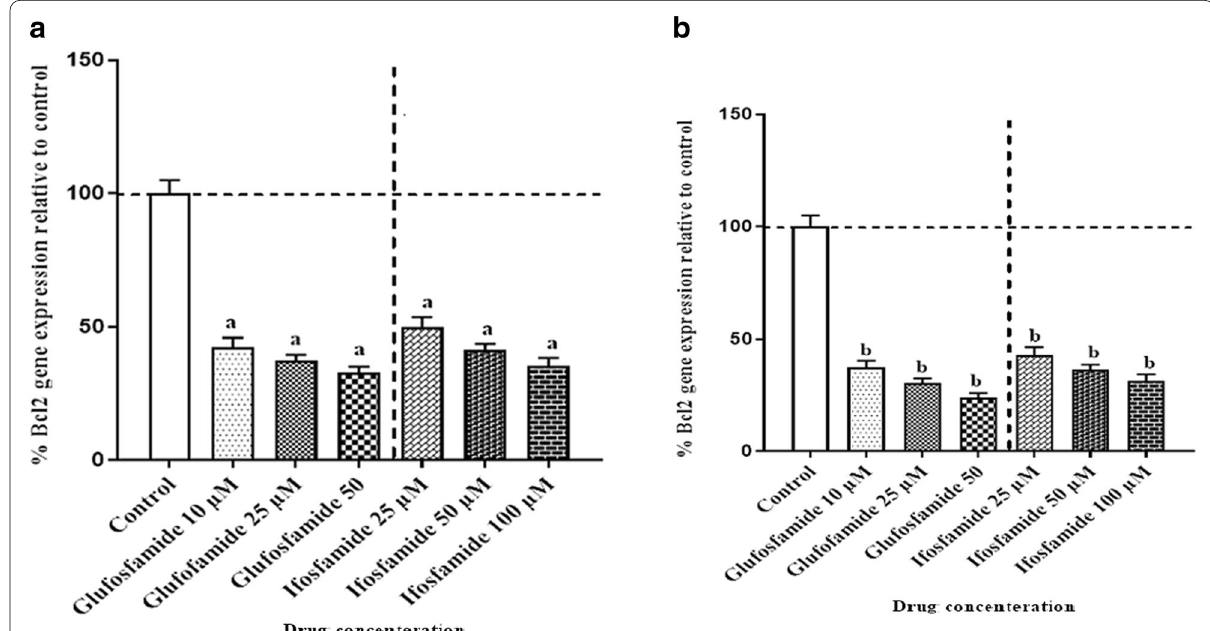
Fig. 5 Effects of glufosfamide and ifosfamide on the gene expression of Bcl2 in HepG2 cells. a Effects of glufosfamide or ifosfamide on the expression of Bcl2 gene in HepG2 cells at 48 h post-incubation using RT-PCR. b Effects of glufosfamide or ifosfamide on the expression of Bcl2 gene in HepG2 cells at 72 h post-incubation using